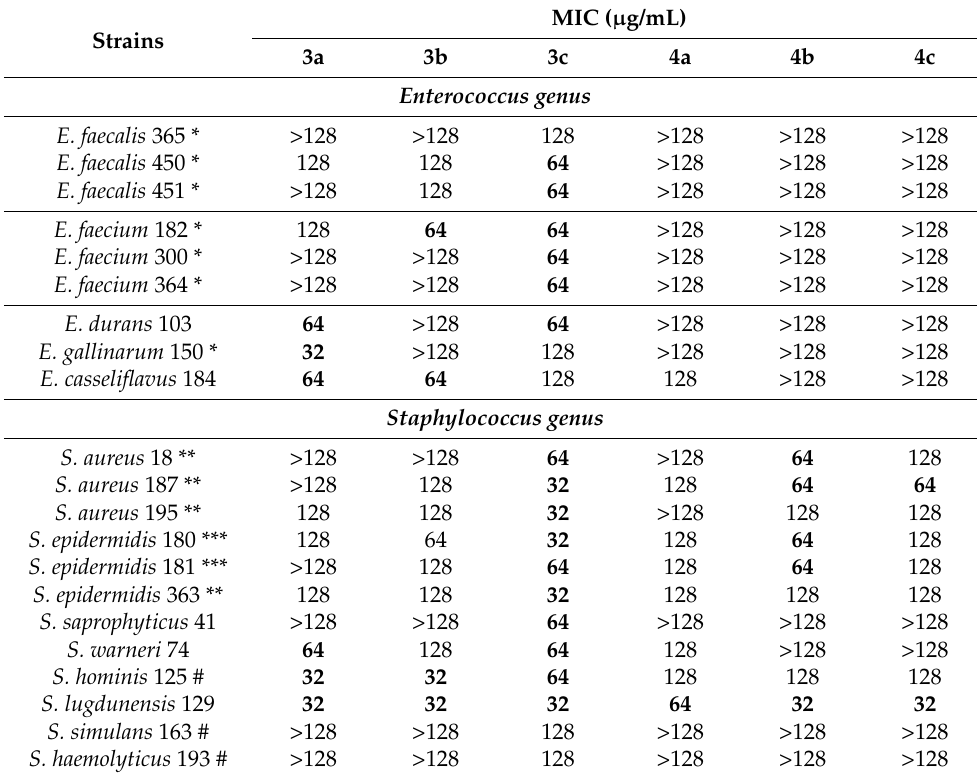
Table 4. MIC values of pyrazoles 3a – c and 4a – c against bacteria of the Gram-positive species, obtained from experiments carried out at least in triplicate, expressed as µ